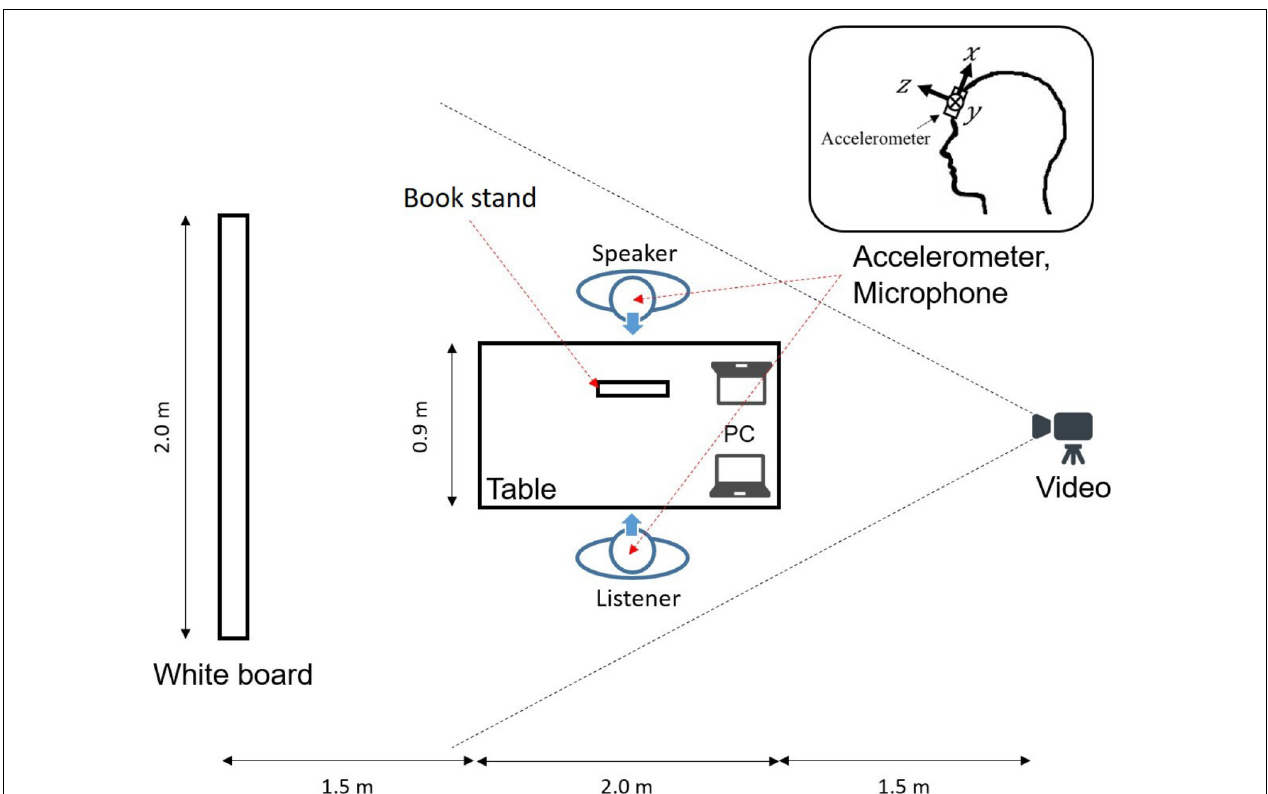
FIGURE 2 | Experiment